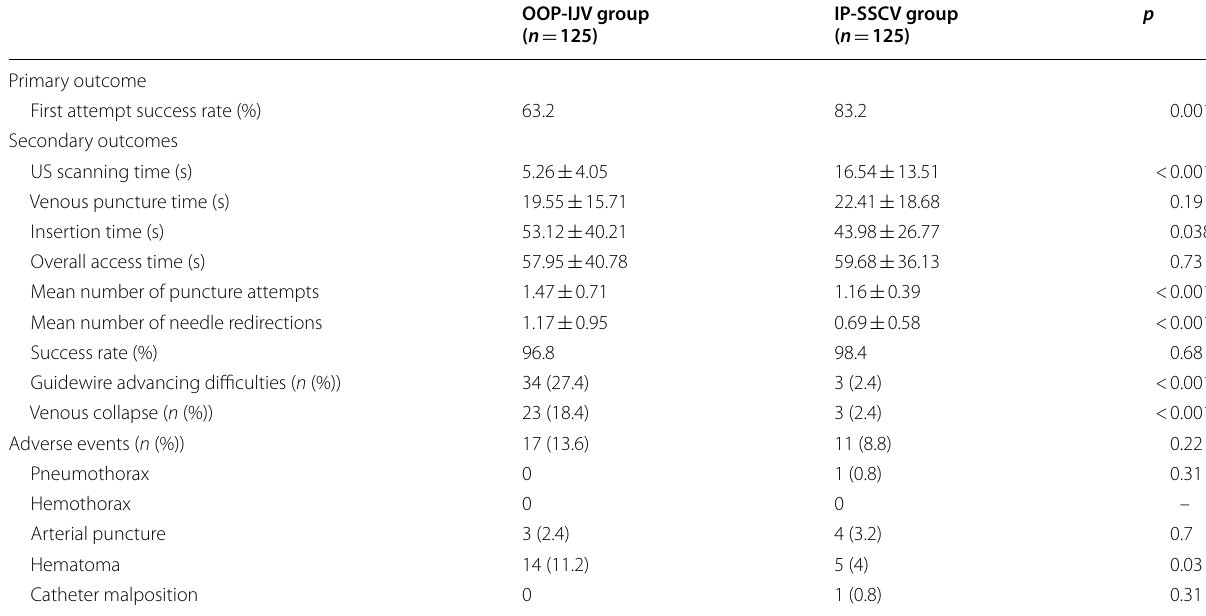
The data were reported as mean The difference is significant at p <